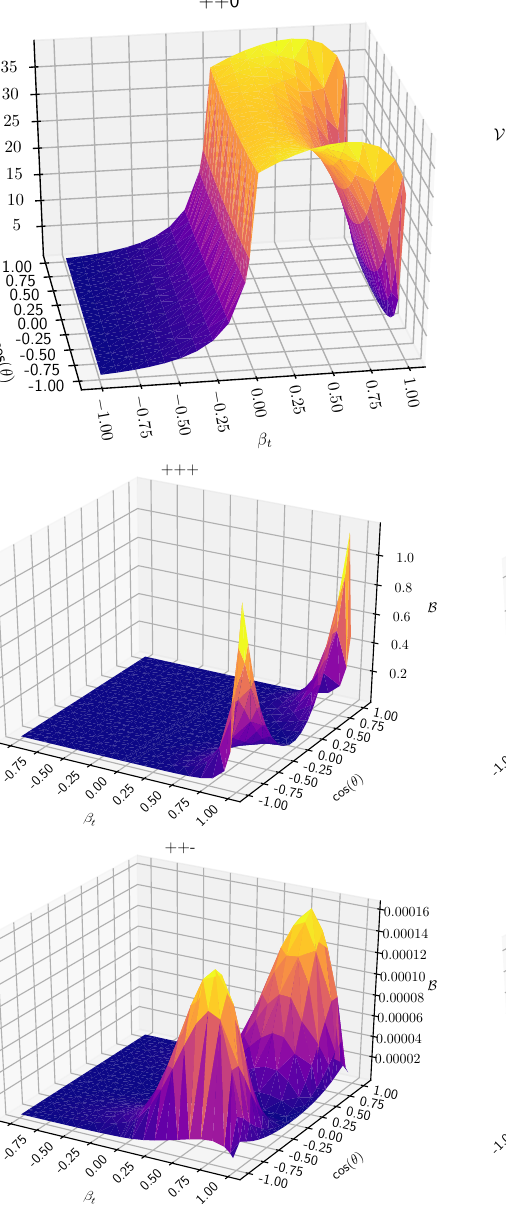
Figure 6 . Dependence of the leading order (left) and virtual contribution (right) on the parameters β t and cos( θ ) for the individual helicity amplitudes with s i = 0